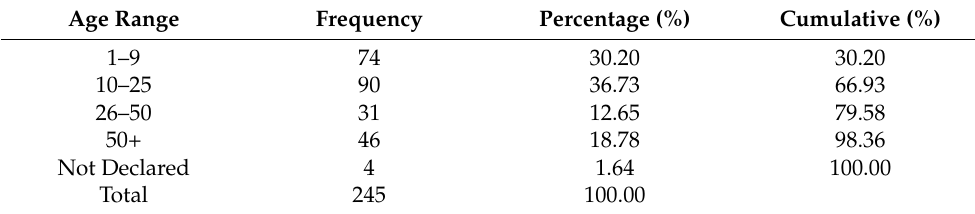
Table 1. Firms age distribution, frequencies, and percentages (N = 245). Source: Author